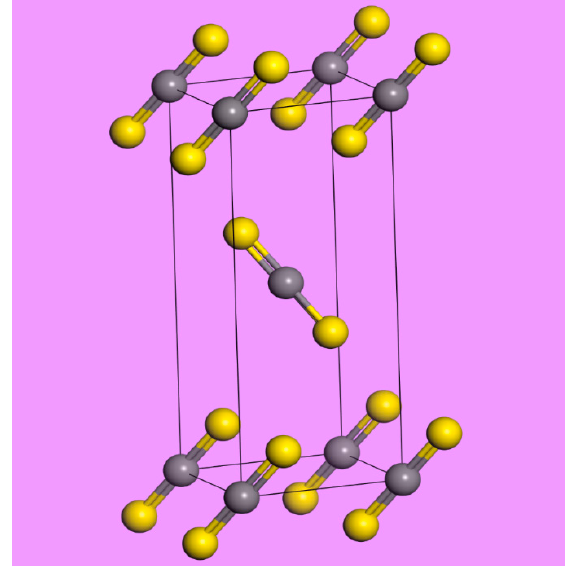
Figure 1. The primitive unit cell of carbon disulfide. Grey = carbon, yellow = sulfur.